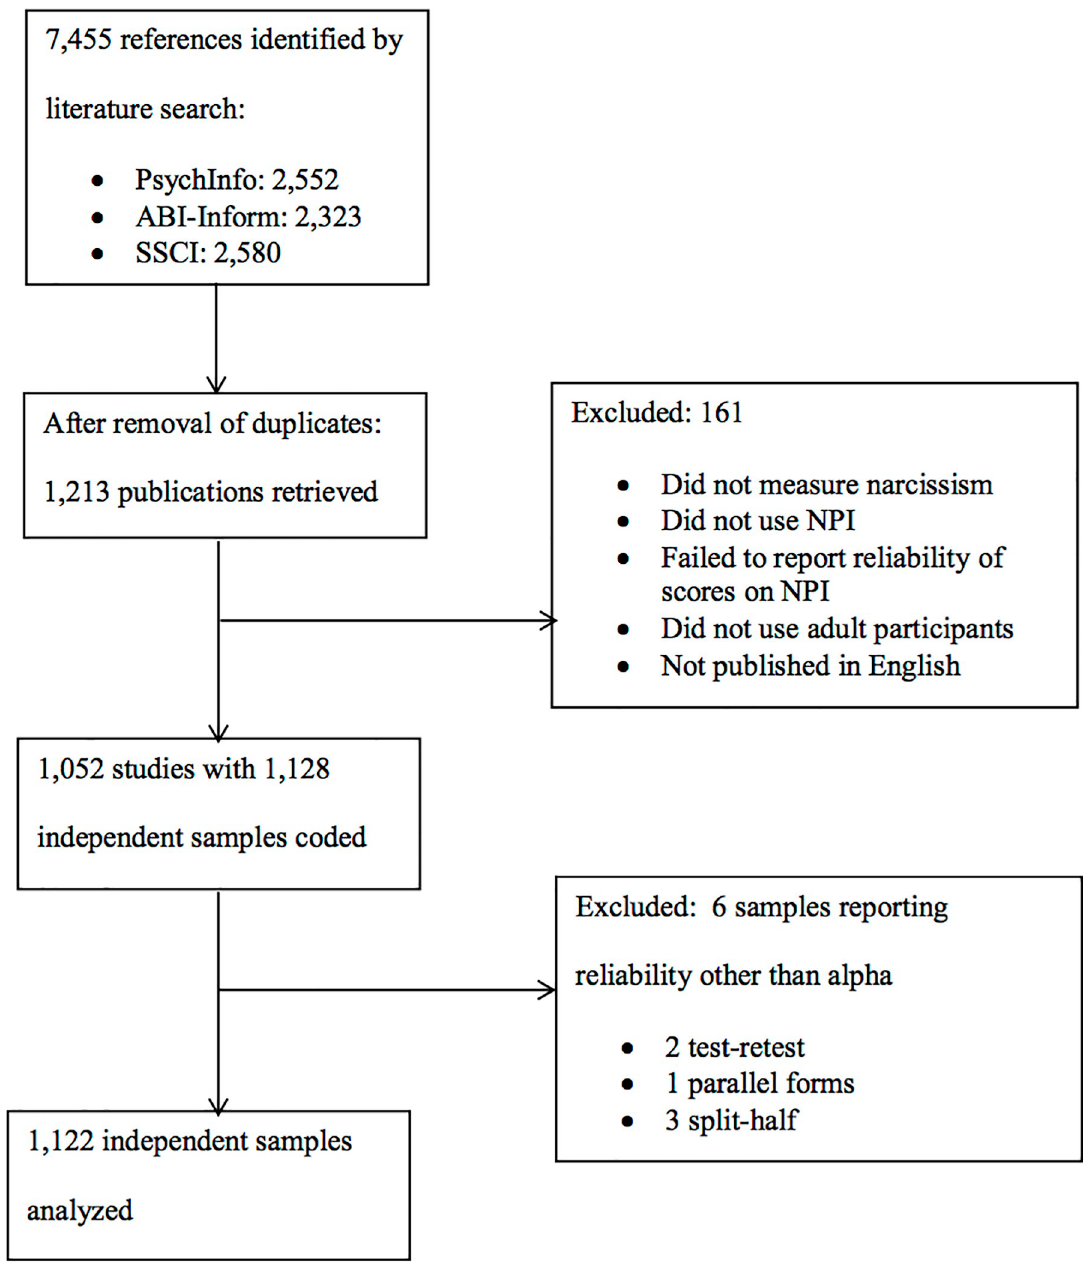
Fig 1. Flowchart for study selection. The steps below were used to identify and select studies for